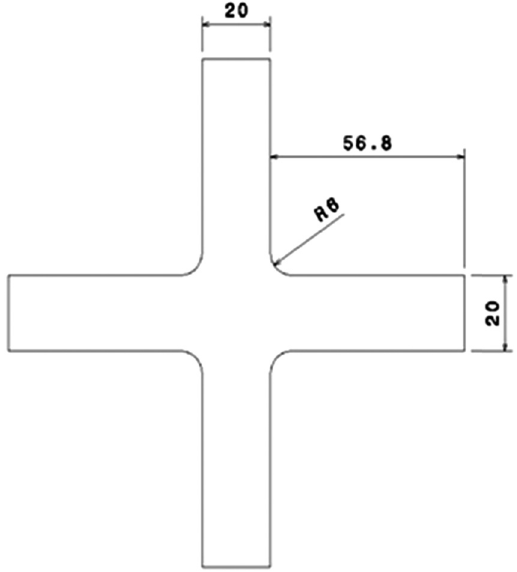
Figure 2: Sample ’ s geometry and dimensions ( in mm )